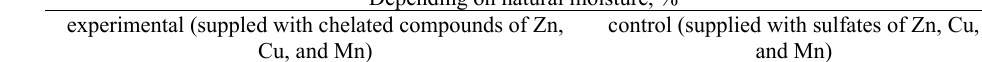
Chemical composition of broiler meat in terms of diet enrichment with sulfates of Zinc, Copper, and Manganese and chelated compounds of these micronutrients (M ± m, n = 10) Depending on natural moisture, % experimental (suppled with chelated compounds of Zn, control (supplied with sulfates of Zn, Cu, Indicators Cu, and Mn) and Mn) red muscles white muscles red muscles white muscles Moisture, % 72.37 ± 0.12 Fat, mg/ Cholesterin